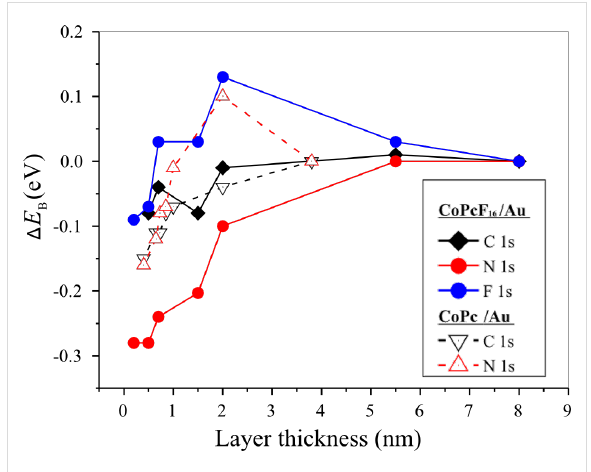
Figure 4: Comparison of energetic core level shifts as a function of the organic film thickness for CoPcF 16 and CoPc on polycrystalline